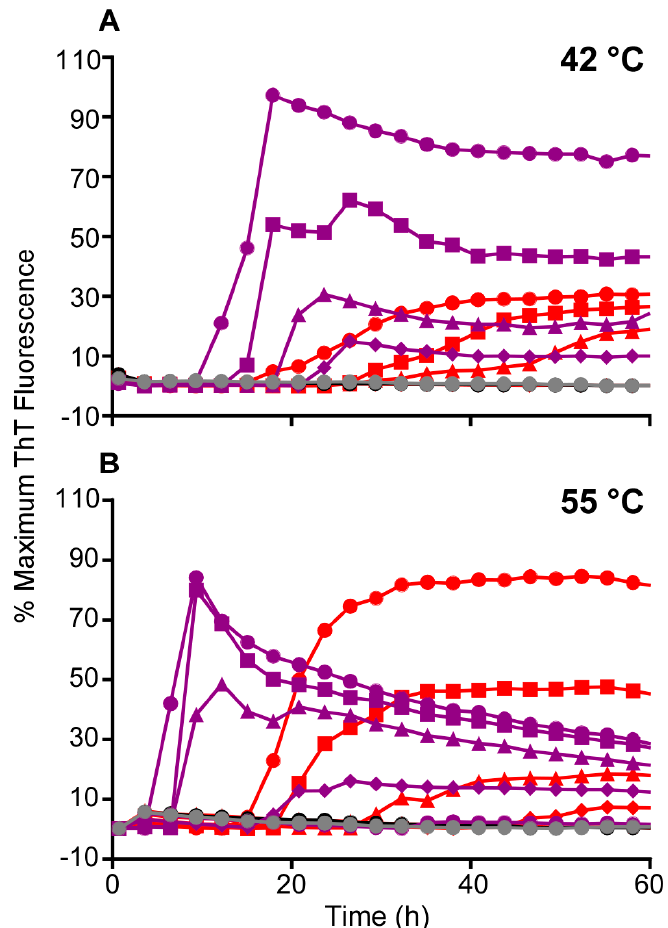
Figure 3. Comparison of RT-QuIC detection of hamster 263K brain homogenate derived seeding activity using Ha 23–231 or 90–231 at 42 and 55 °C. Quadruplicate RT-QuIC reactions were seeded with serial dilutions of 5 × 10 − 7 ( ), 5 × 10 − 8 ( ), 5 × 10 − 9 ( ▲ ) and 5 × 10 − 10 ( ) of hamster 263K scrapie strain positive brain homogenate. Negative control reactions were seeded with a 5 × 10 − 7 dilution of hamster normal brain homogenate (black and gray traces for Ha 23–231 and Ha 90–231 rPrPSen, respectively). The reactions were incubated at either 42 °C (A) or 55 °C (B) using Ha 23–231 (red) or 90–231 (purple) rPrPSen as substrate. The increase of the average normalized ThT fluorescence of replicate wells is plotted as a function of time. Although ThT readings were taken every 45 min, for visual clarity, the curves report only readings at 135-min intervals. We have observed similar enhancements of the speed of the reactions in two additional experiments.